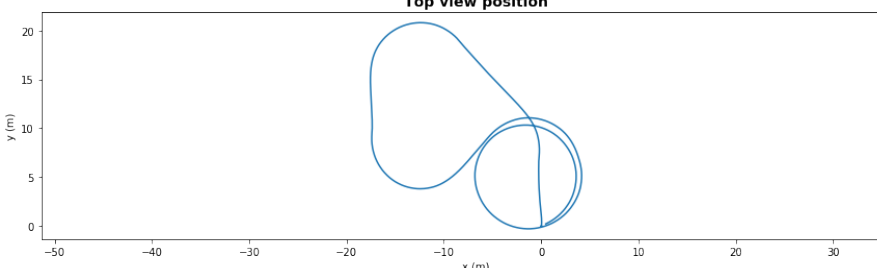
Figure 5. waypoint mission—nominal path.